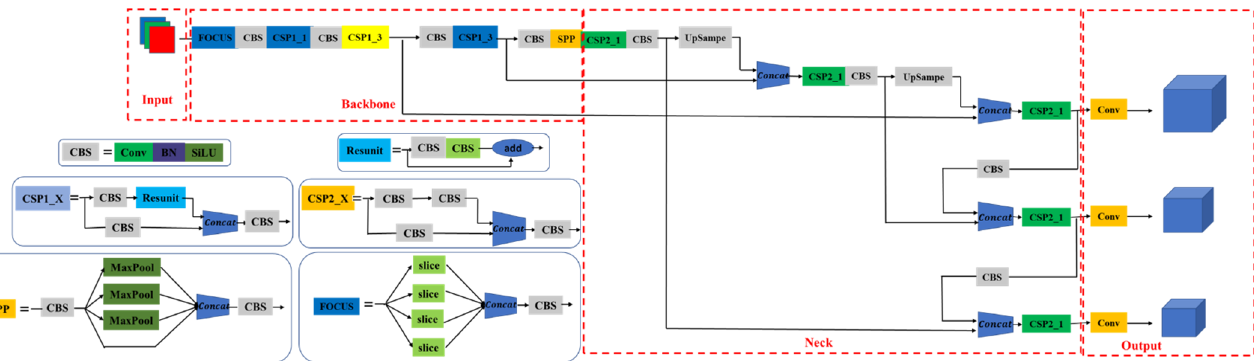
Figure 3. Network structure diagram of YOLOv5.